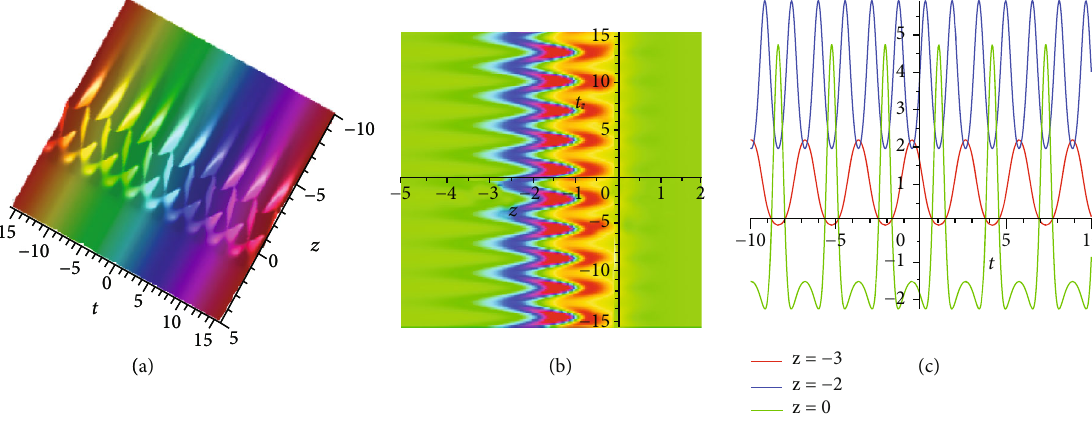
Figure 2: Plots of interaction lump with two solitons